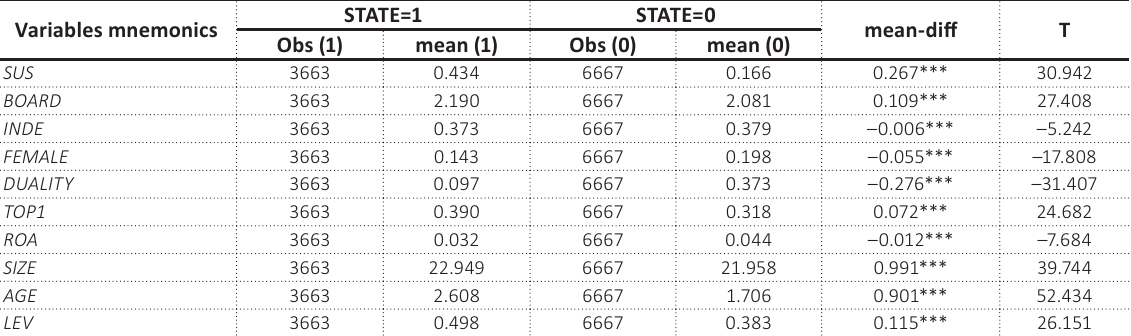
Source: Developed by the authors.